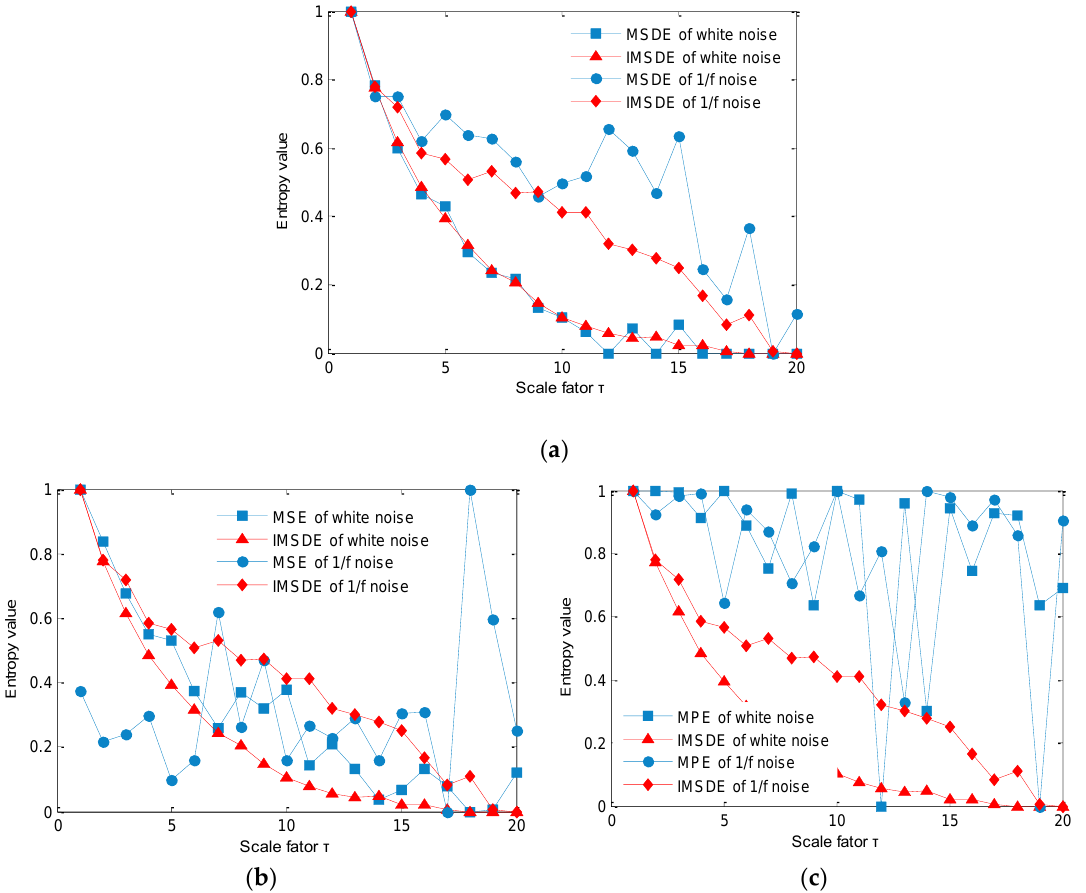
Figure 5. Comparison of multiscale entropy: ( a ) multiscale symbolic dynamic entropy (MSDE) and improved multiscale symbolic dynamic entropy (IMSDE), ( b ) multiscale sample entropy (MSE) and improved multiscale symbolic dynamic entropy (IMSDE), ( c ) multiscale permutation entropy (MPE) and improved multiscale symbolic dynamic entropy (IMSDE).